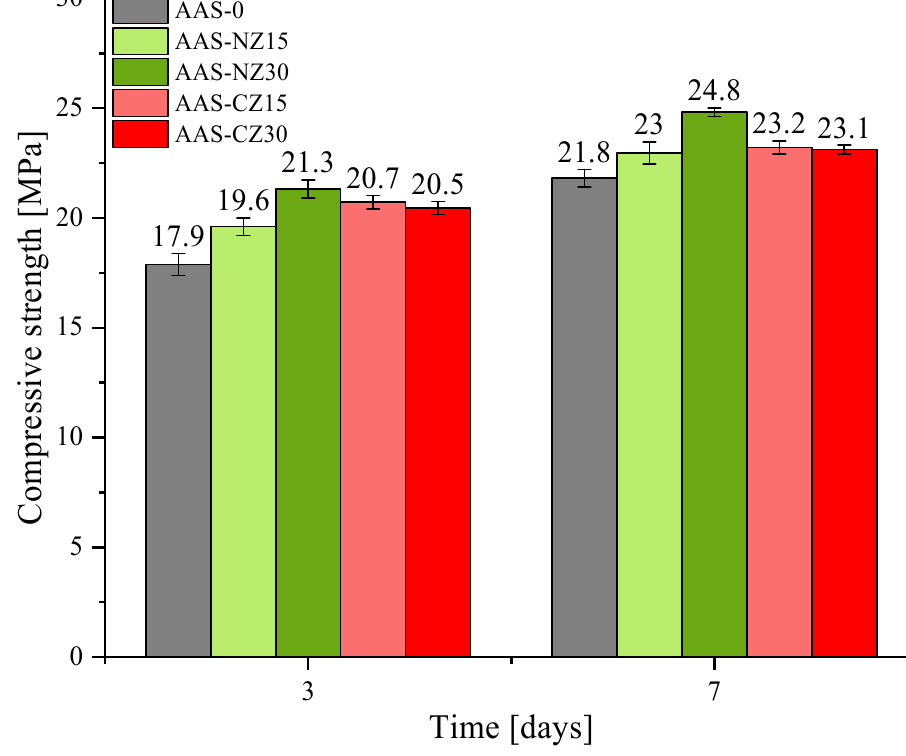
Figure 6. Compressive strength of the alkali-activated slag (AAS) mortars at 3 and 7 days.